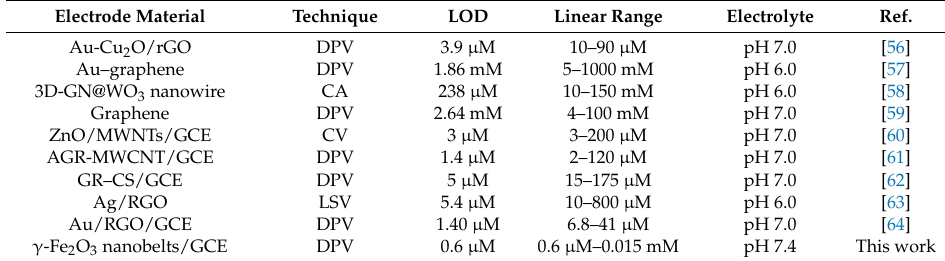
Table 2. Comparison of DA sensor parameters of γ-Fe 2 O 3 nanobelts/GCE and the other electrode materials reported in literature.